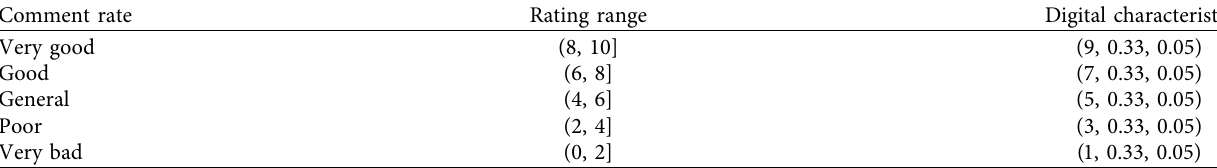
Table 4: Cloud model of comprehensive ability evaluation standard for accounting applied